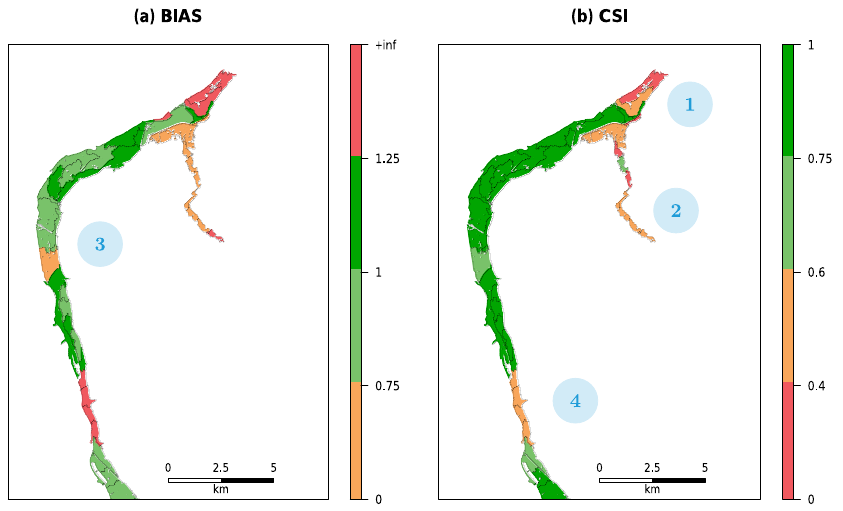
Figure 12. Reach-scale performance of (a) BIAS and (b) CSI for the physical combination of parameters, K ch = 10 and K fp = 5m 1 / 3 s − 1 , for the downstream part of the catchment. Criteria values have been categorised as follows: excellent (dark green), good (green), average (orange) and poor (red). The black lines delineate the reaches. Locations 1 to 4 correspond to areas where the model struggles to reproduce the observation (orange and/or red zones).